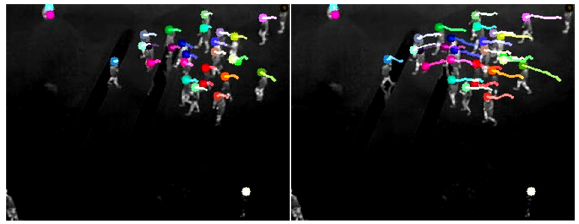
Figure 8. Result of motion corners detection and tracking.